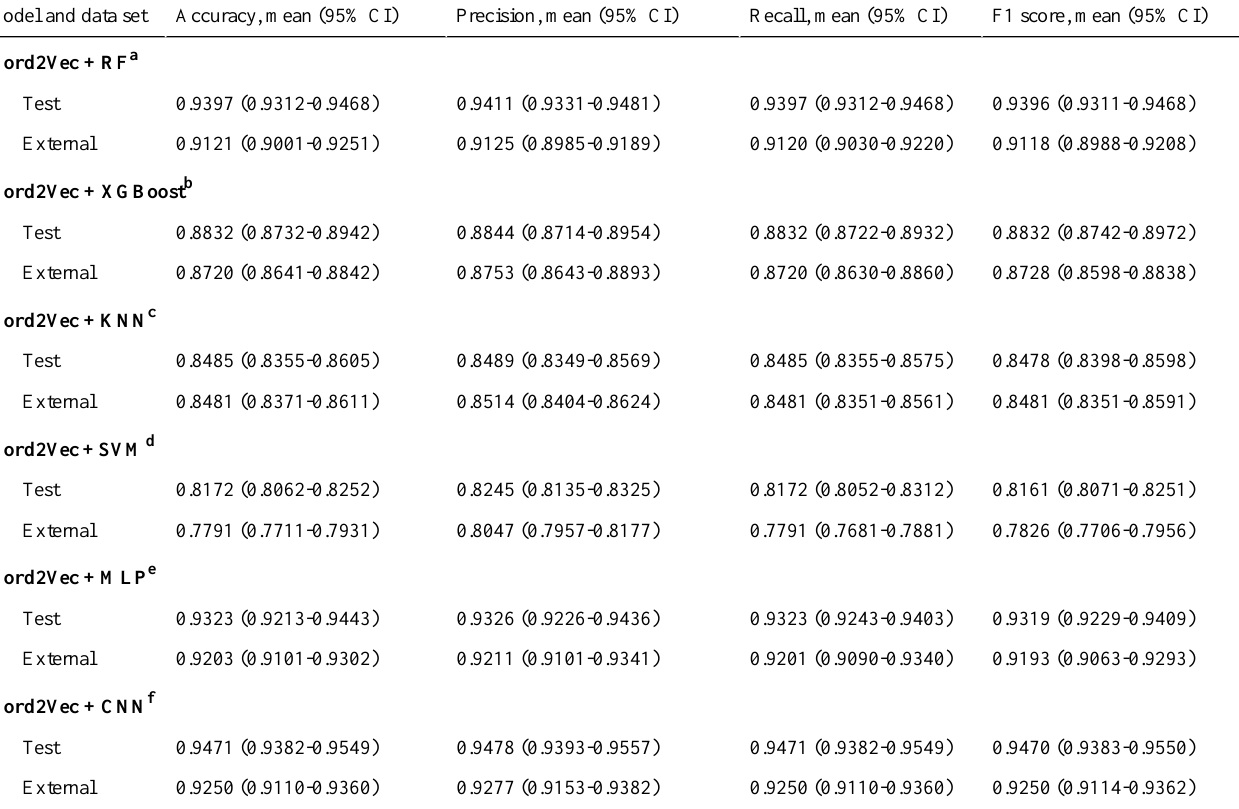
Table 1. Performance analysis of model-based reasoning methods applied for syndrome pattern diagnosis of lung disease based on Word2Vec in the test and external data